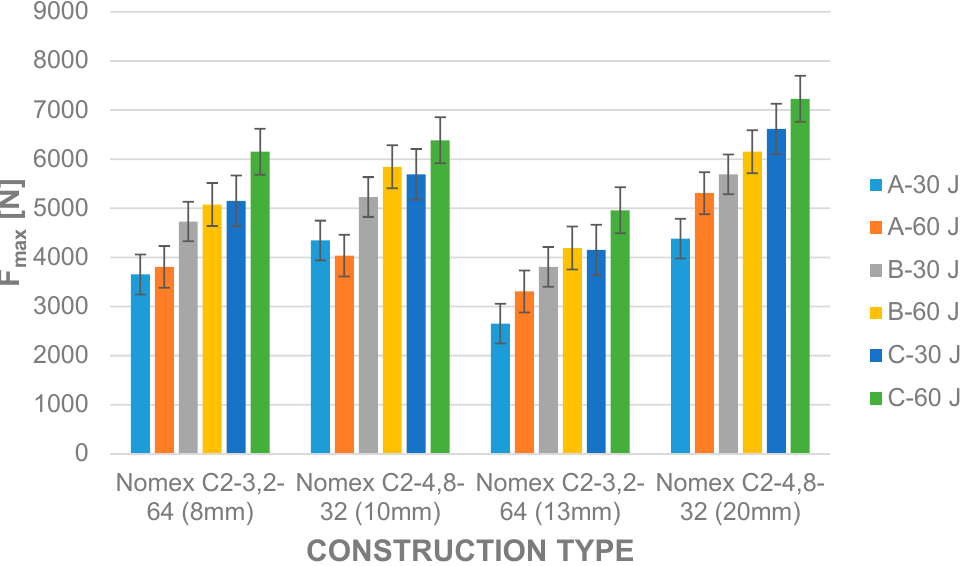
Figure 21. Influence of core thicknesses; the honeycomb used of various geometry C2-3.2-64 (W orientation).